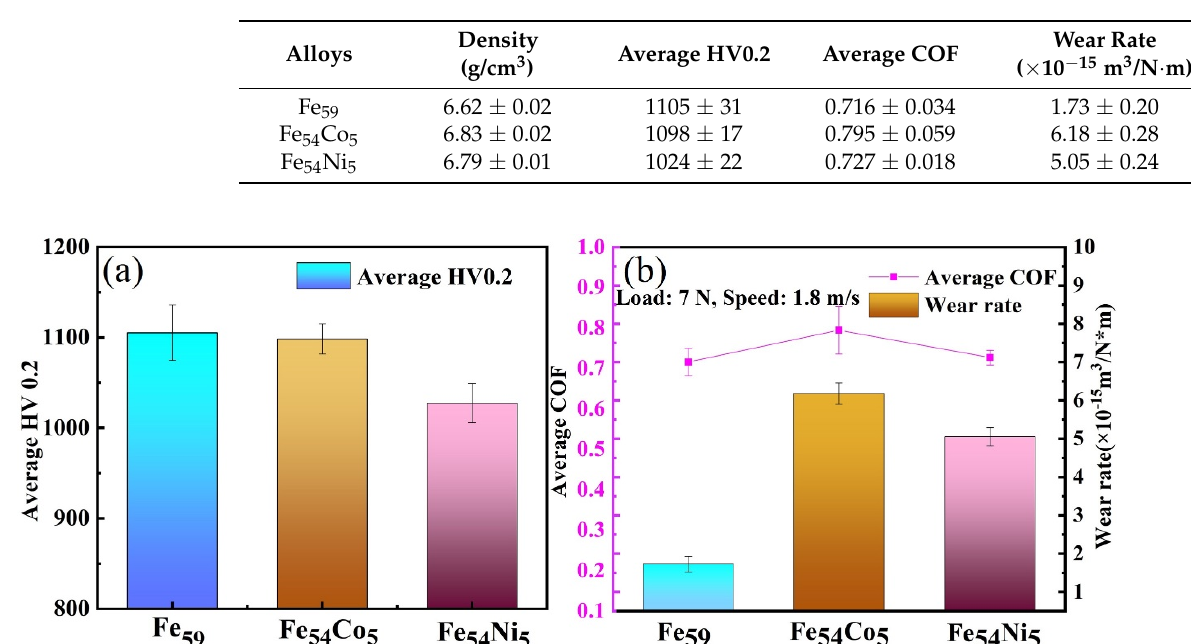
Table 3. Density, average microhardness, average COF, and wear rate of the Fe 54 M 5 Cr 15 Mo 6 Si 2 B 4 P 10 C 4 (M = Fe, Ni, and Co) BMGs.